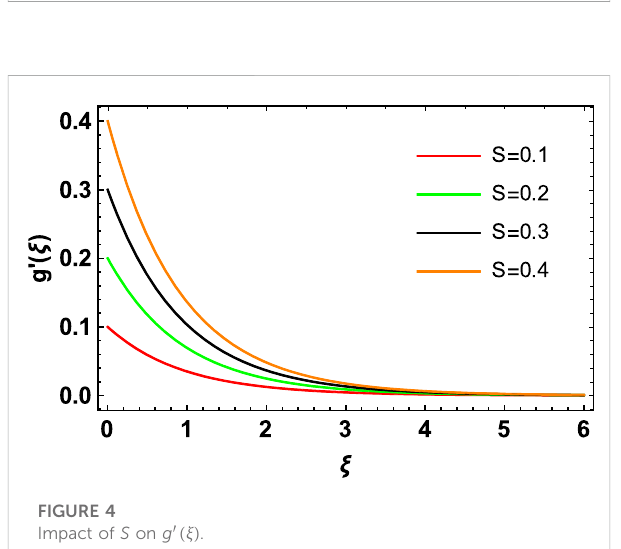
FIGURE 2 Impact of H on f ′ ( ξ ) .